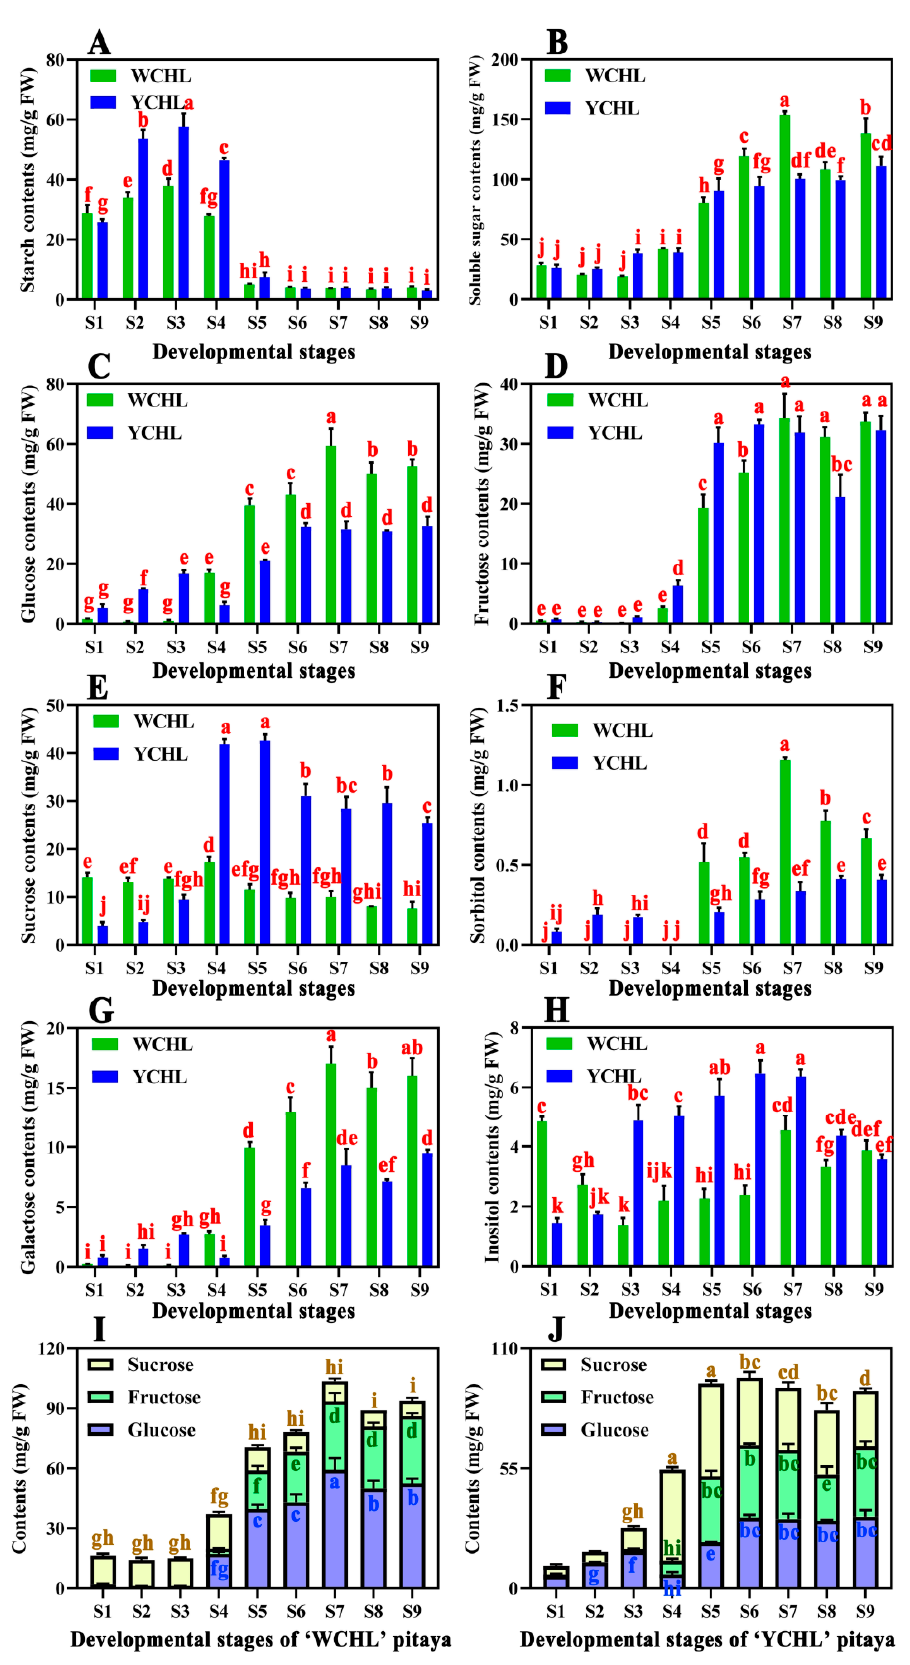
Figure 3. Changes in sugar contents in pulps during fruit developmental stages of ‘WCHL’ and ‘YCHL’ pitayas. ( A ) Starch contents; ( B ) soluble sugar contents; ( C ) glucose contents; ( D ) fructose contents; ( E ) sucrose contents; ( F ) sorbitol contents; ( G ) galactose contents; ( H ) inositol contents; ( I )